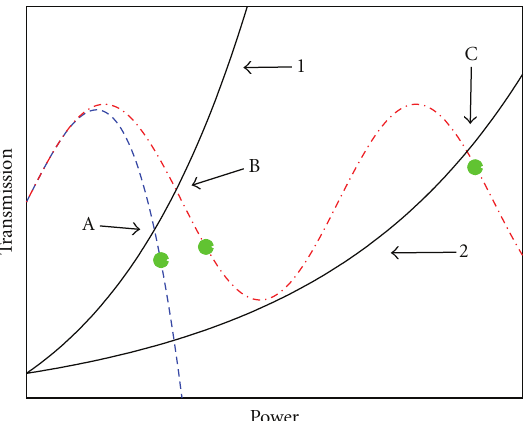
Figure 6: The red dash-dot line and the blue dashed line represent the transmission of the SGLE and the CQGLE, respectively. The black solid lines denote the saturating gain curves. The intersection of the gain and transmission curves represents a stable mode-locked pulse. The green circles are the maximum power allowed in the laser cavity. When energy is increased, gain curve 1 shifts towards gain curve 2, causing the mode-locked pulses A and B to exceed the maximum power allowed. In the CQGLE, the solution jumps to the next most energetically favorable configuration of a double-pulse solution (not shown). A high-energy single-pulse solution (point C) can exist in the SGLE model (from [29], 2011,